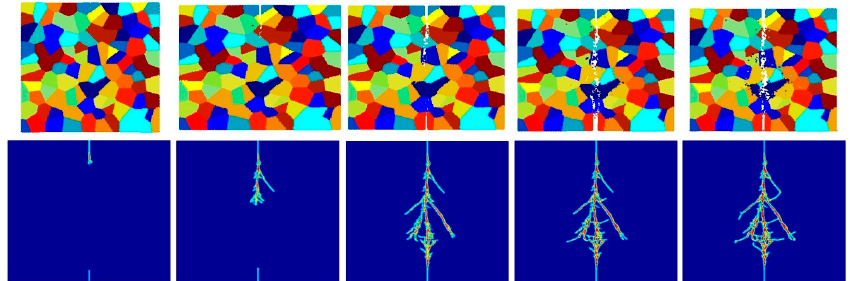
Figure 22. Fracture pattern of polycrystal when β = 2.0 with 300 × 300 particles. From left to right: time = 1.5 μ s, 2.0 μ s, 2.5 μ s, 3.0 μ s, and 3.5 μ s, respectively.